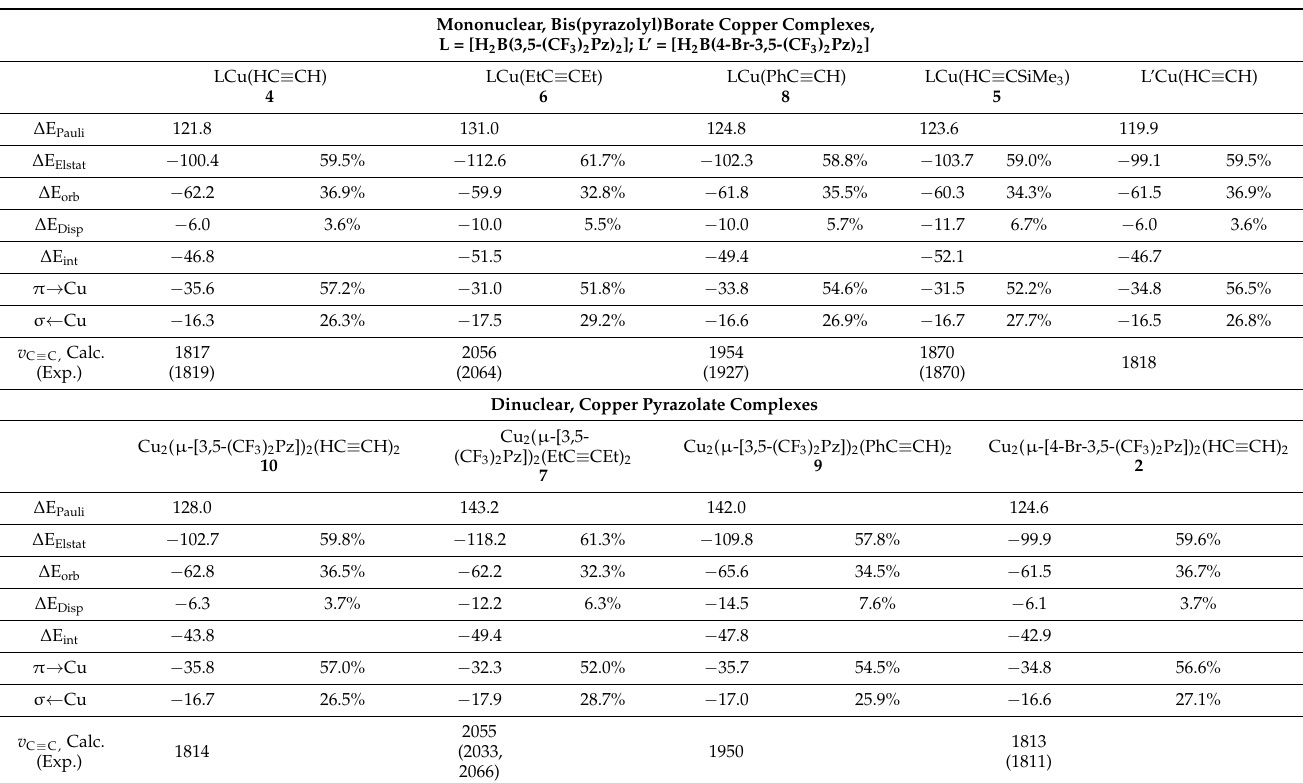
Table 2. Energy decomposition analysis of the interaction energy in mononuclear and dinuclear Cu(I) species. Values in kcal · mol − 1 . Vibrational frequencies in cm − 1